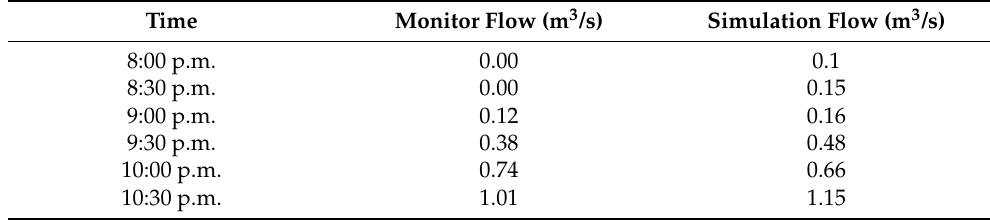
Table 2. Monitoring flow and simulated flow on 12 July